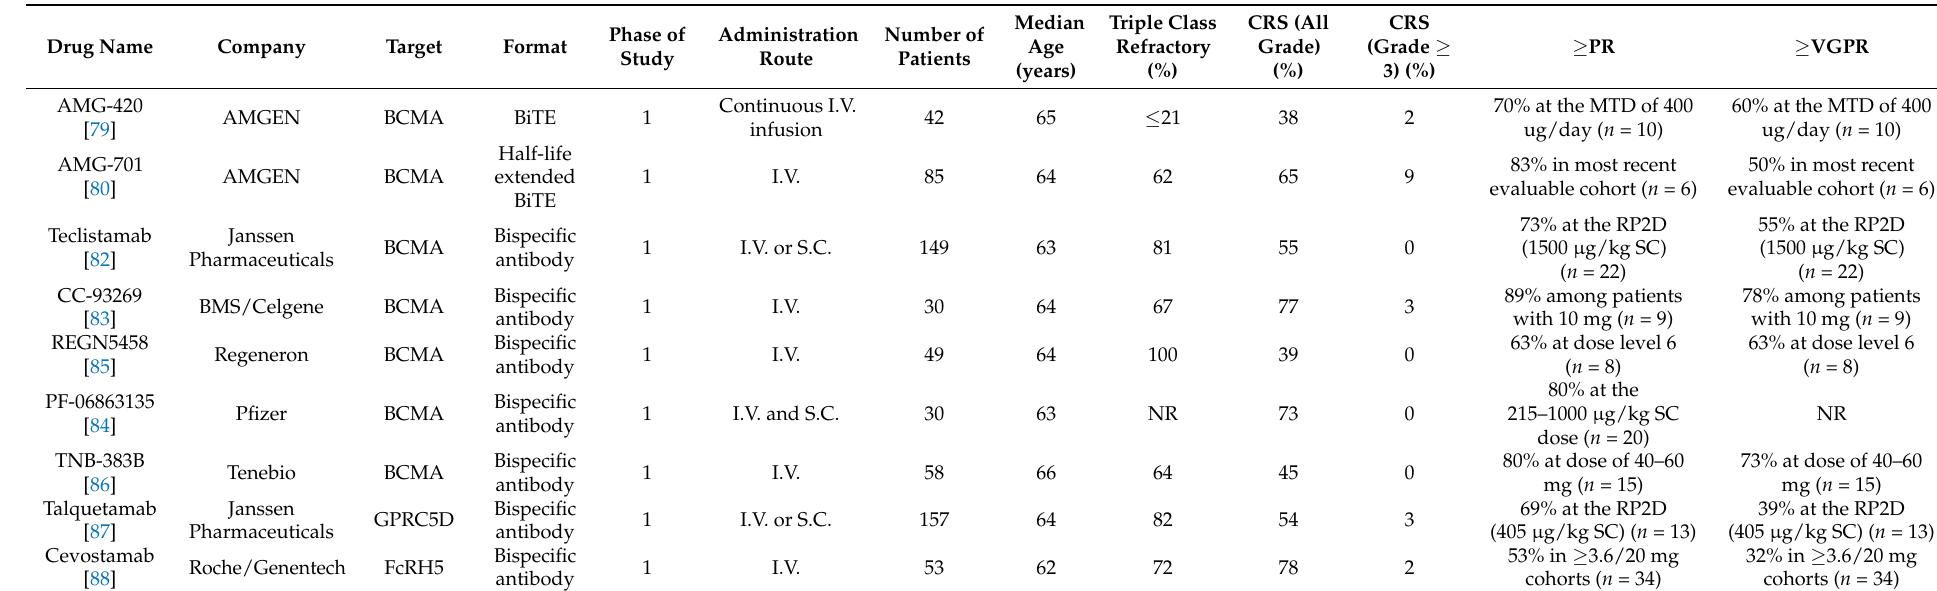
Table 4. Selected studies with bispecific T cell